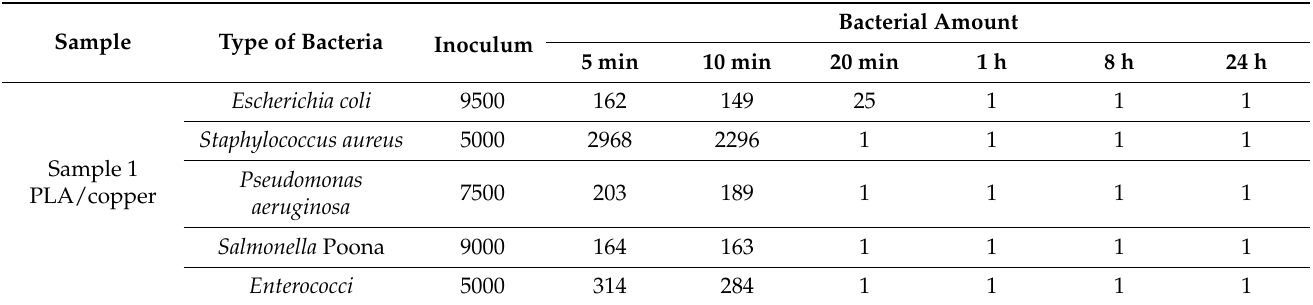
Table 2. Bacterial count on PLA/copper sheet over different time